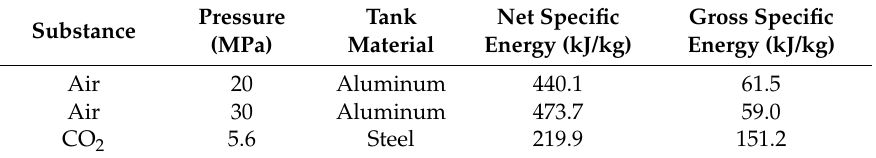
Table 6. Specific energy per mass of fuel and mass of system for air and carbon dioxide, based on